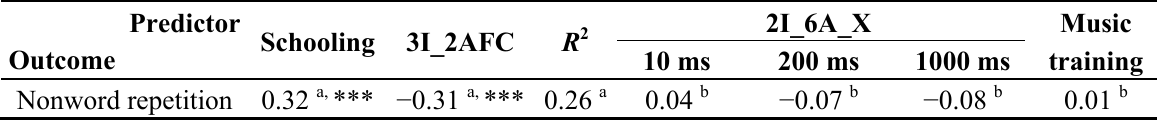
Table 3. Summary of the standardised regression coefficients for the two frequency discrimination tasks (2I_6A_X and 3I_2AFC), schooling and music training for predicting nonword repetition ability. a Values indicate significant regression weights for the variables remaining in the final model. b Nonsignificant regression weights observed during early exploratory analyses. *** p <